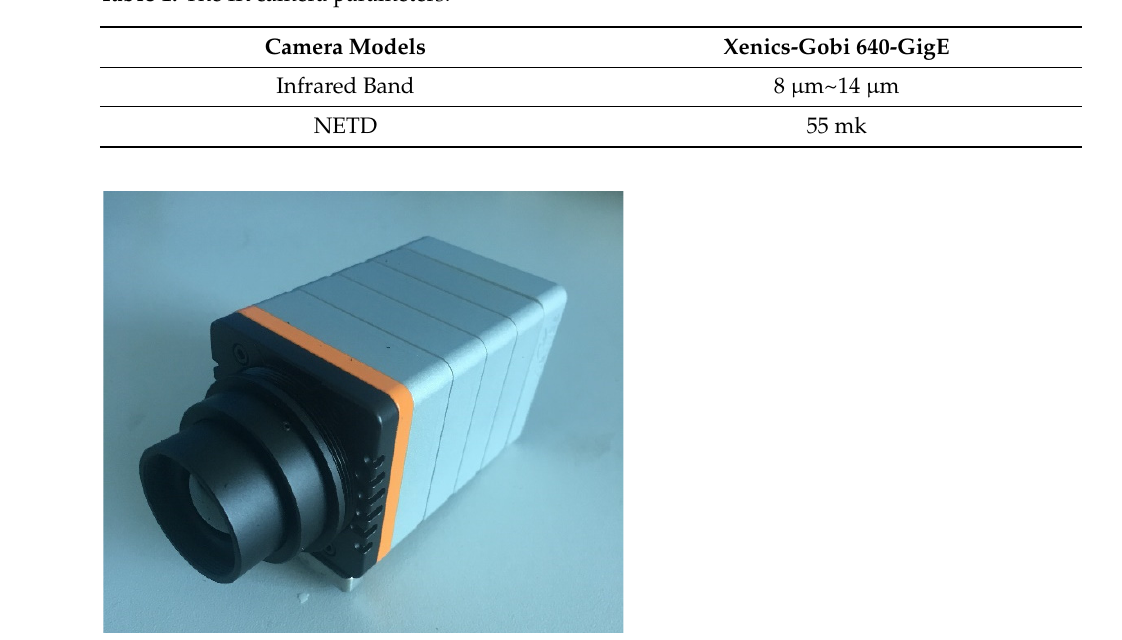
Table 1. The IR camera parameters.